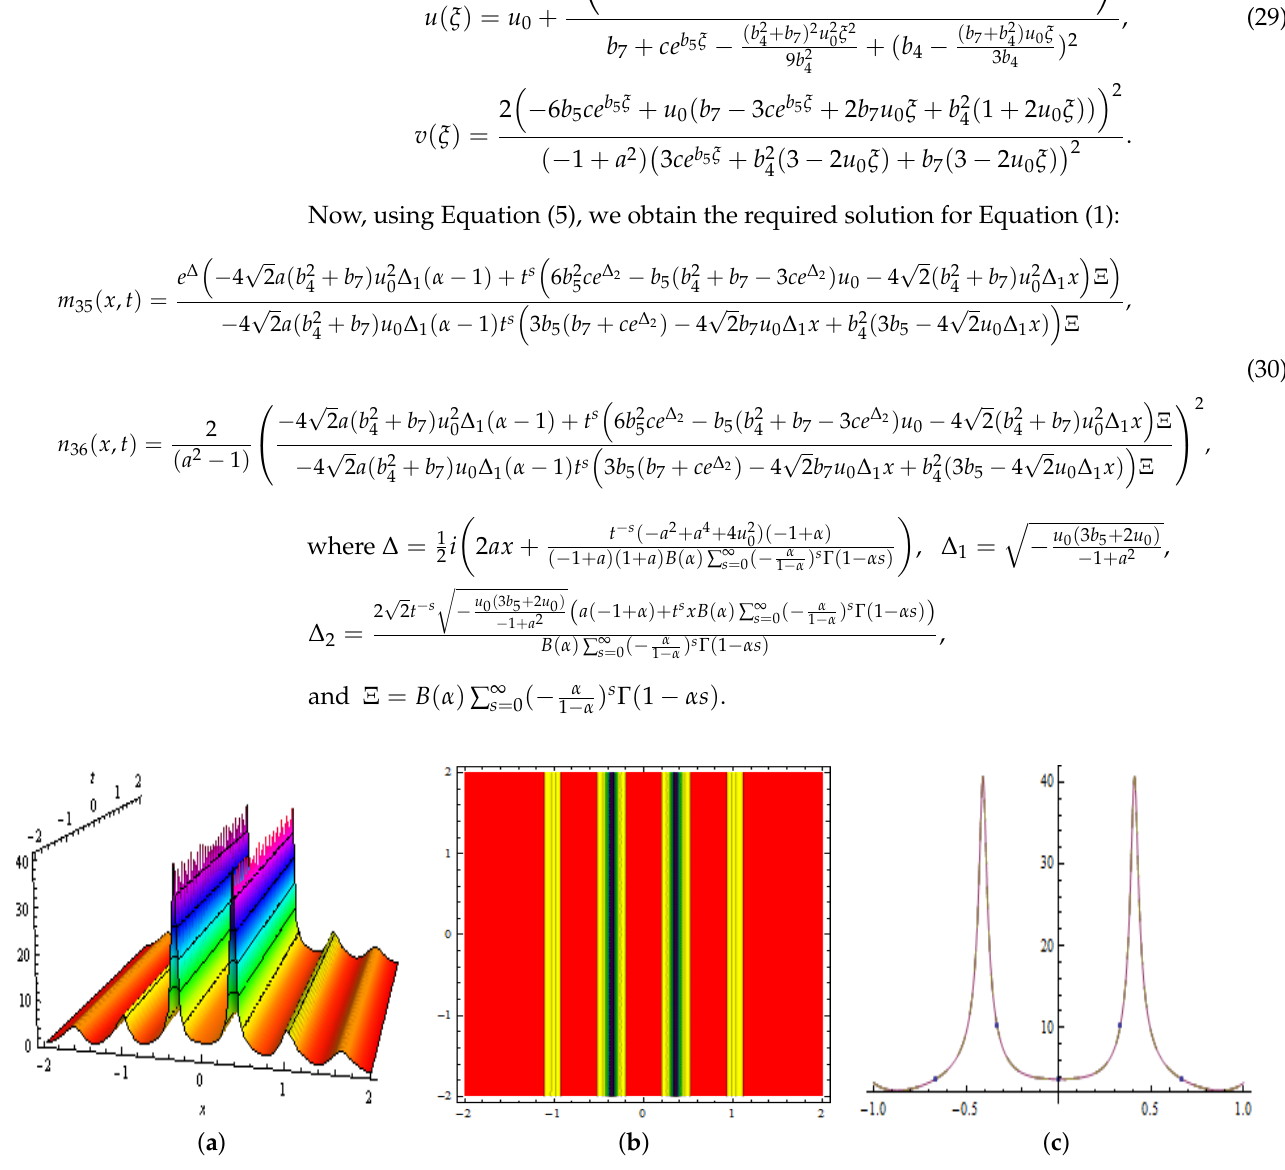
Figure 5. clarify three-dimensions in ( a ); contour in ( b ) and two-dimensions in ( c ), Plots of m 35 ( x , t ) in Equation (30) for a = 0.5, u 0 = 1, b 4 = 2, b 5 = − 4, b 7 = − 3, c = 1, α = 0.8,